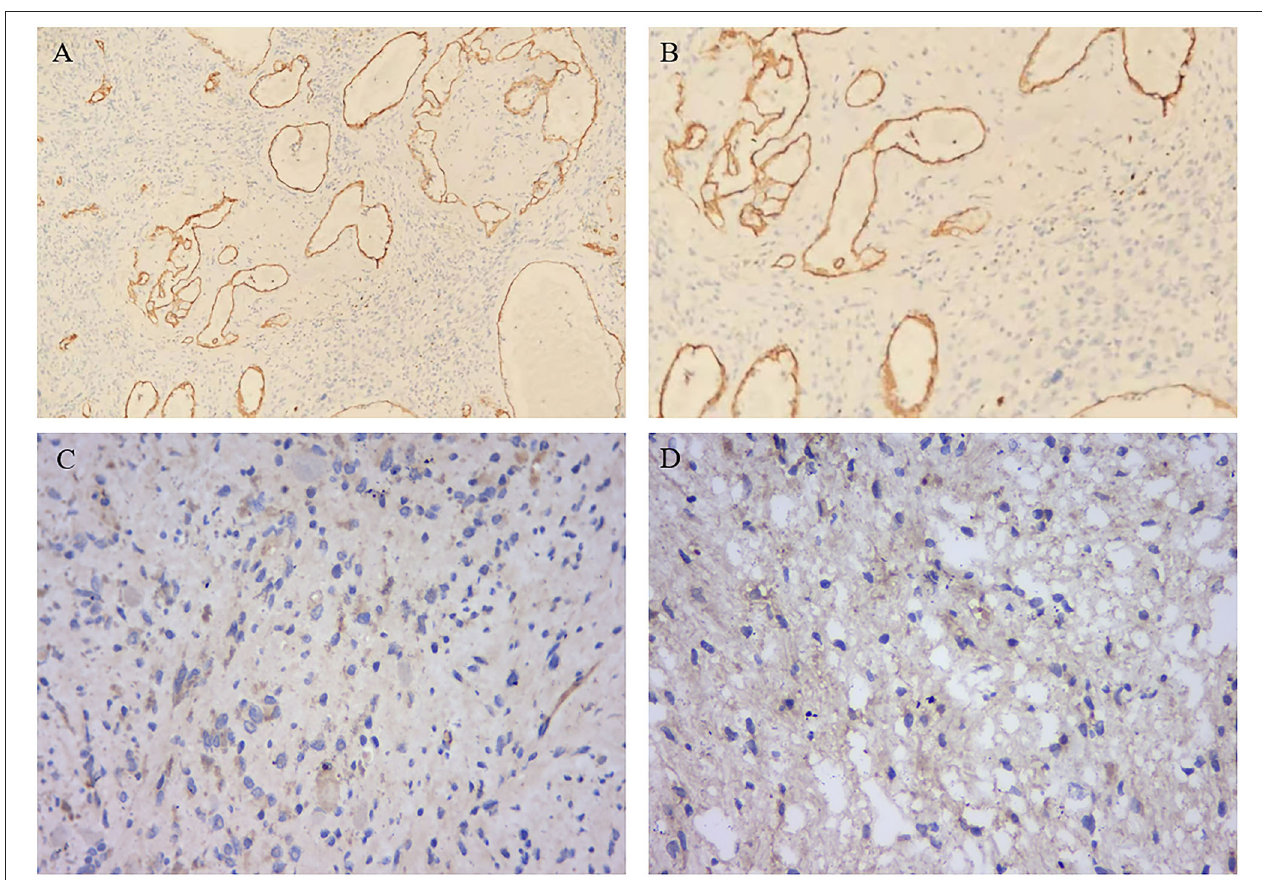
FIGURE 2 | Representative immunohistochemical staining of microvessel density and VEGF in PTBE group. (A) Low-magnification view of MVD. (B) High-magnification view of MVD. (C) Low-magnification view of VEGF staining. (D) High-magnification view of VEGF staining. MVD, microvessel density; VEGF, vascular endothelial growth factor; PTBE, peritumoral brain